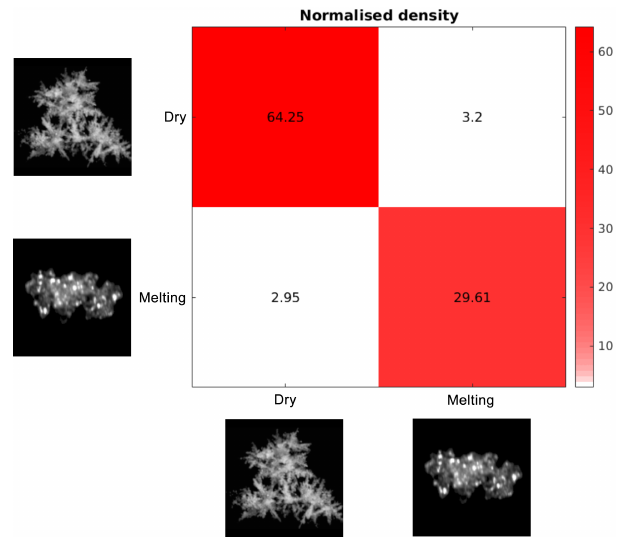
Figure 11. Same as in Fig. 6 but for melting snow detection.